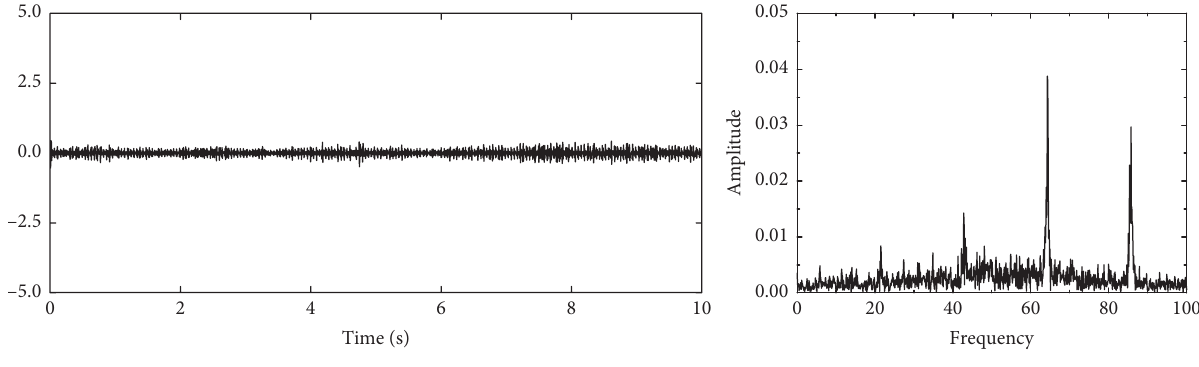
Figure 15: IMF4 and its FFT spectrum.